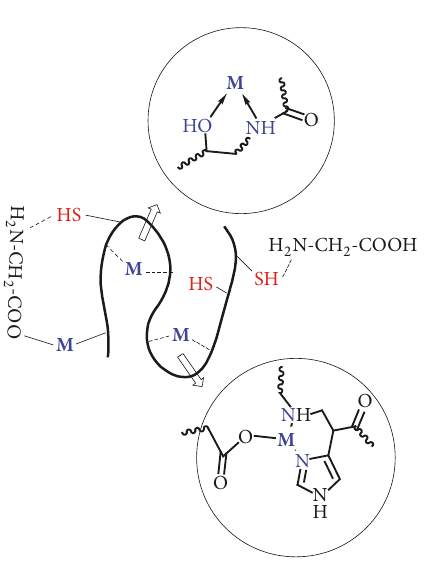
Scheme 2: The active center for O 2∙− scavenging of